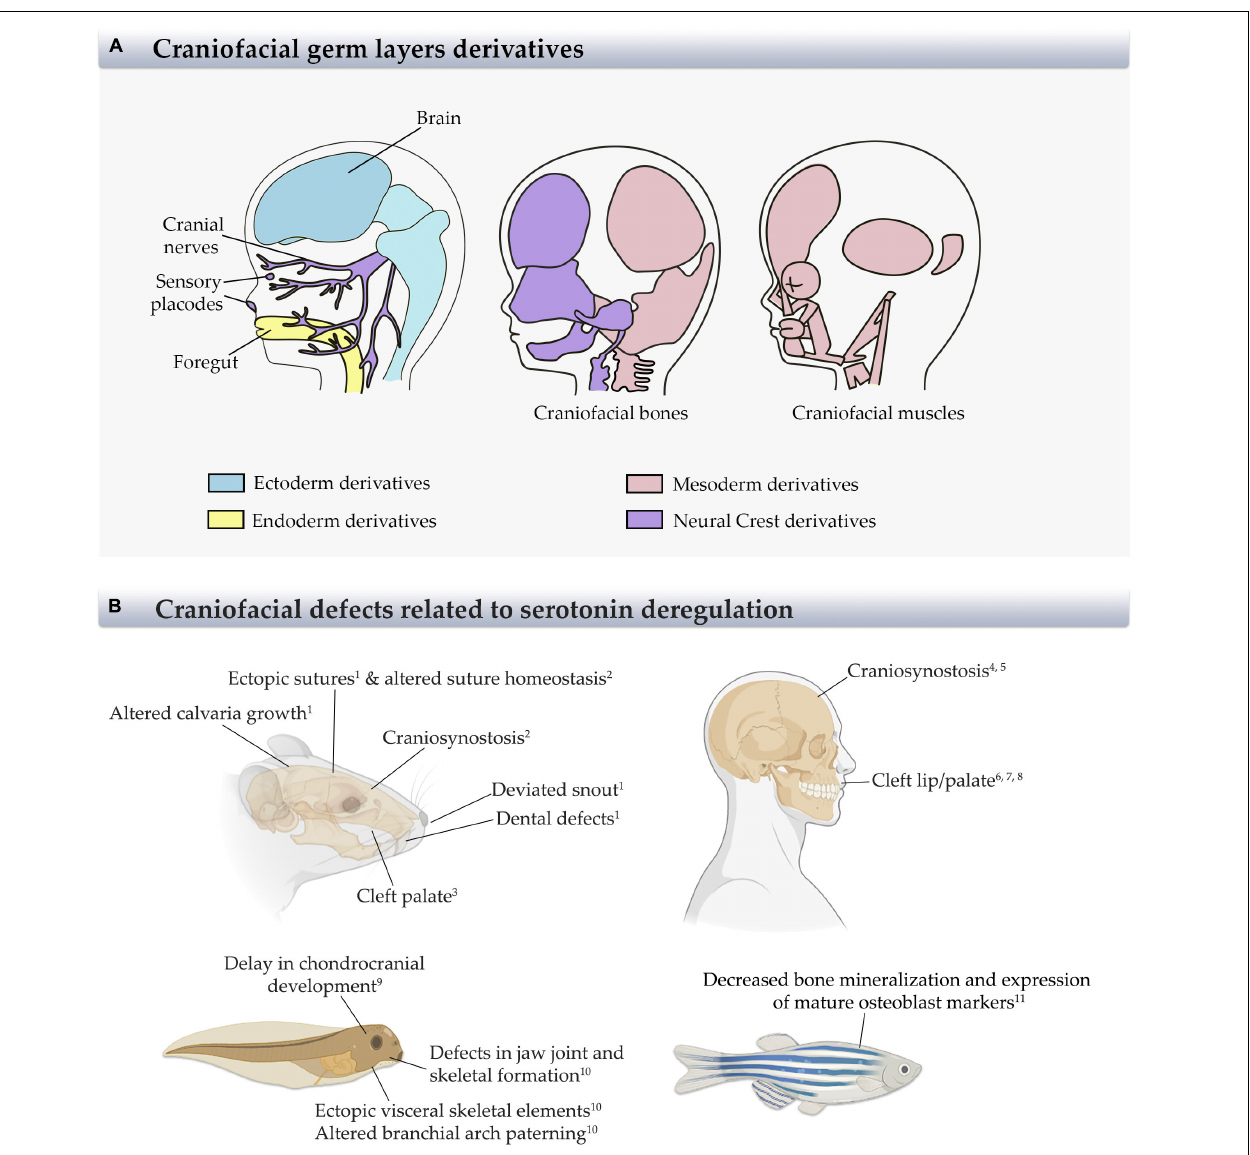
FIGURE 1 | Derivatives structures from germ layers and craniofacial defects in different animal models and humans. (A) Scheme of the craniofacial derivatives from ectoderm, mesoderm, endoderm, and neural crest (NCs) showing the main craniofacial structures and the germ layer from which they came. Modified from Carlson (2019). (B) Scheme of animal models and humans indicating the most relevant craniofacial defects generated by serotonin deregulation, as reported. References: 1 Cray et al., 2014; 2 Durham et al., 2019; 3 Cabrera et al., 2020; 4 Berard et al., 2017; 5 Alwan et al., 2007; 6 Colvin et al., 2011; 7 Louik et al., 2007; 8 Malm et al., 2011; 9 Calibuso-Salazar and Ten Eyck, 2015; 10 Reisoli et al., 2010; 11 Fraher et al., 2016.